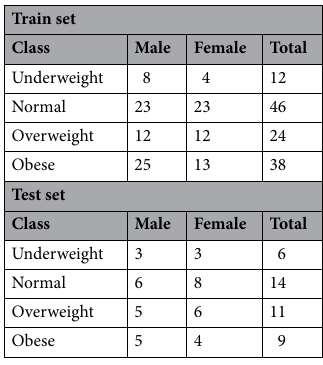
Table 4. Subject class distribution.